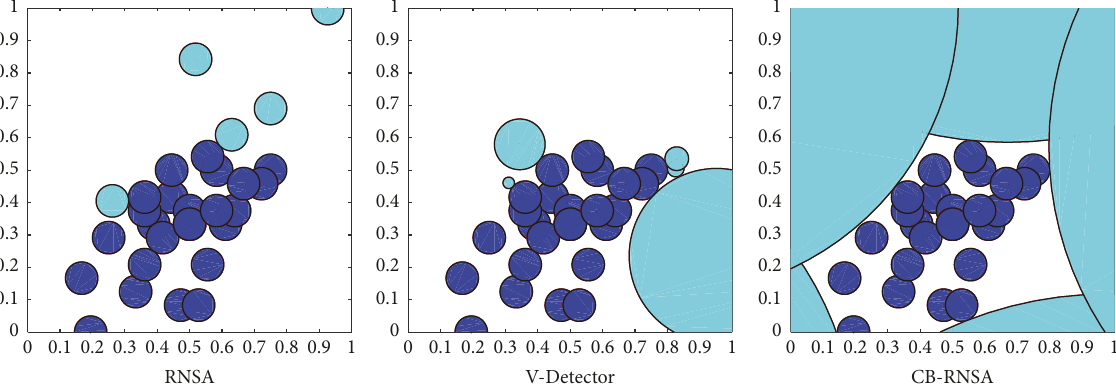
Figure 6: Contrast between CB-RNSA, RNSA, and V-Detector (five mature detectors are produced at the same